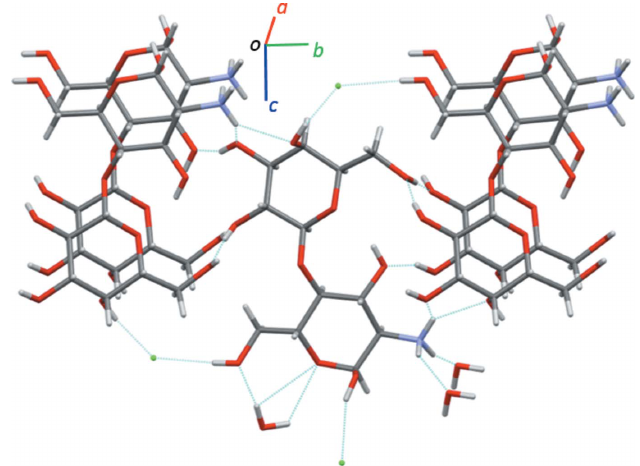
Figure 3 Hydrogen-bonded lactosamine molecular ions, chloride ions, and water molecules surrounding the central lactosamine molecular ion in the crystal structure of ( I ).